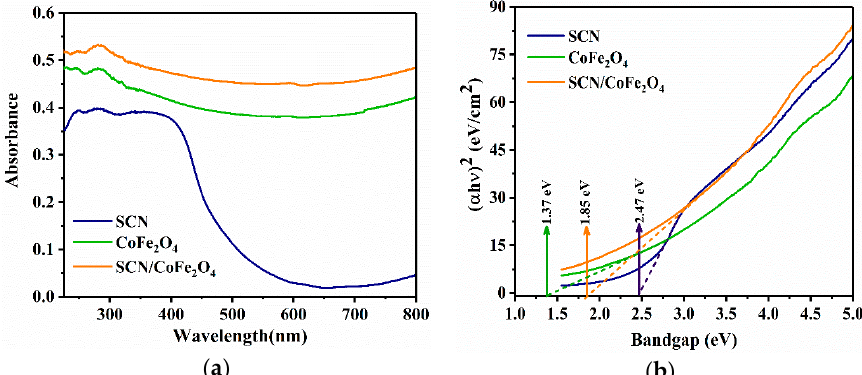
Figure 3. ( a ) UV-Vis spectra of SCN, CoFe 2 O 4 , and SCN/CoFe 2 O 4 nanocomposite; ( b ) ( α h ν ) 2 vs. bandgap energy.